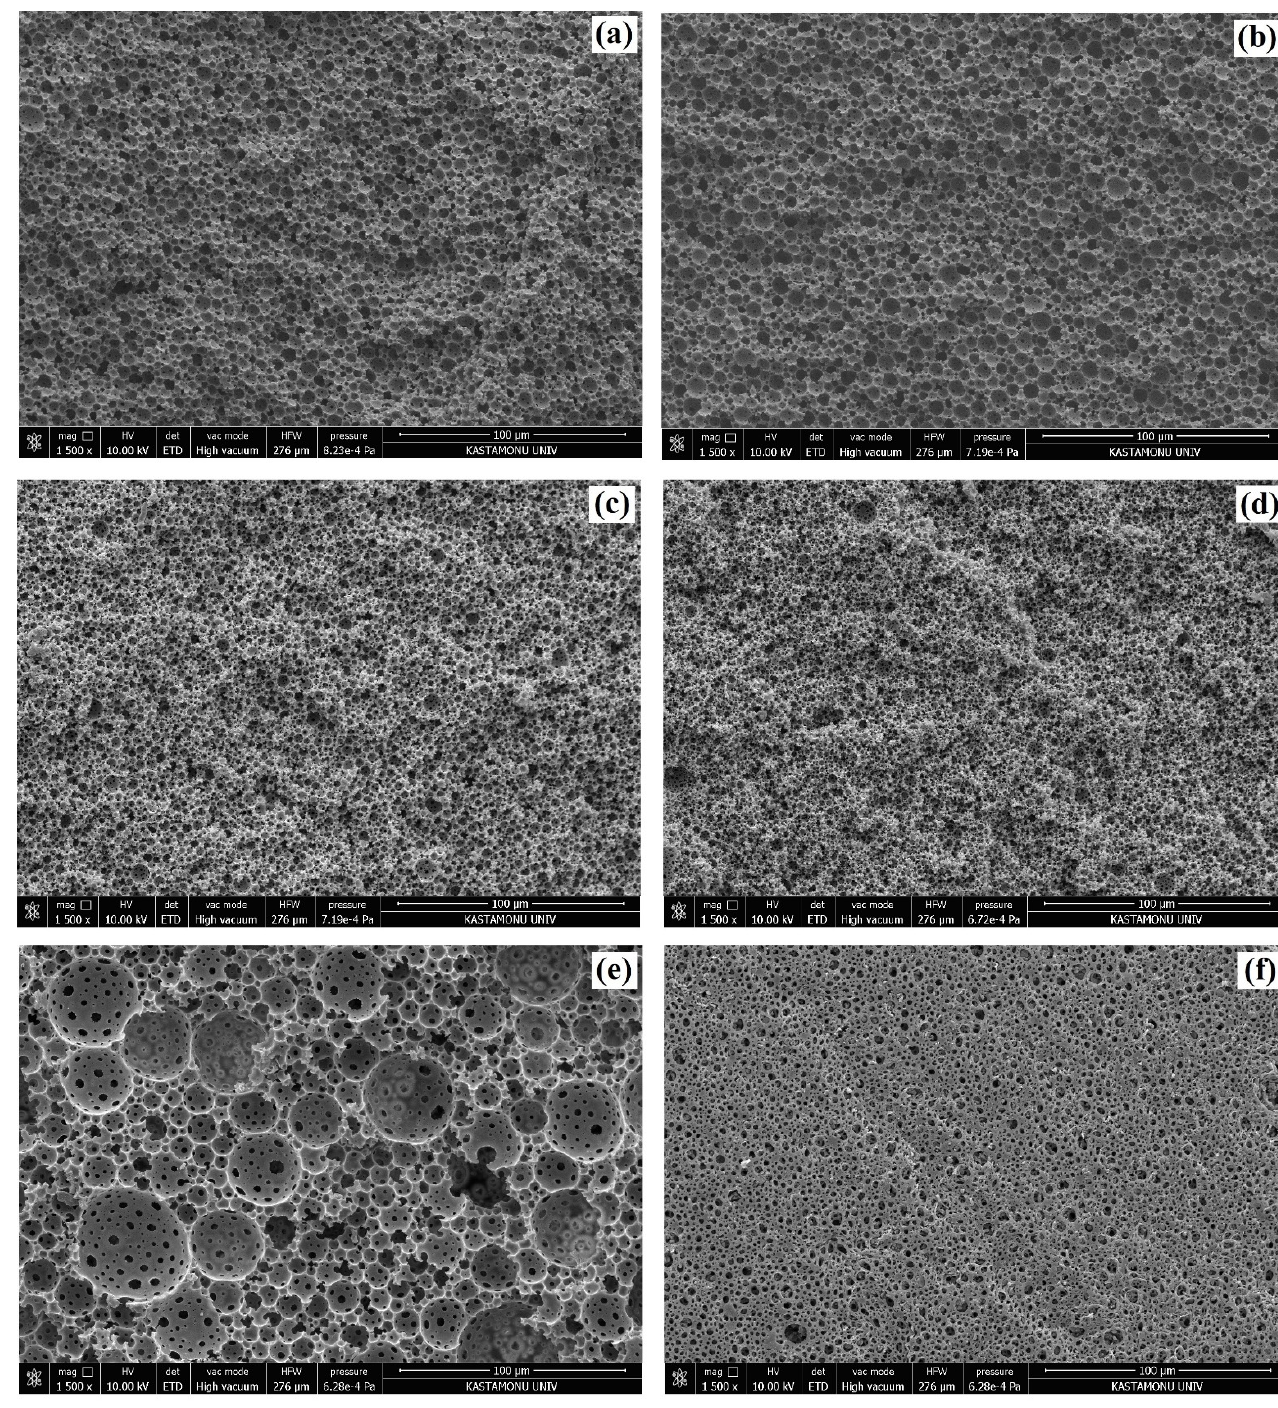
Figure 3. SEM images of polyDCPD composites: ( a ) 1-KP, ( b ) 2-KP, ( c ) 3-KP, ( d ) 4-KP, ( e ) 5-KP, and ( f ) 6-KP.